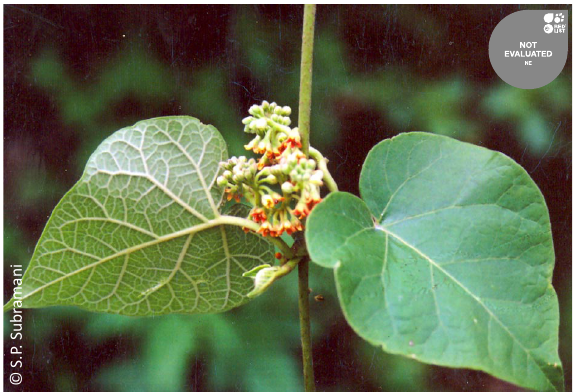
Image 15. Pergularia roylei (Wight) D.